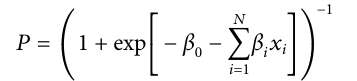
Frontiers in Earth Science |